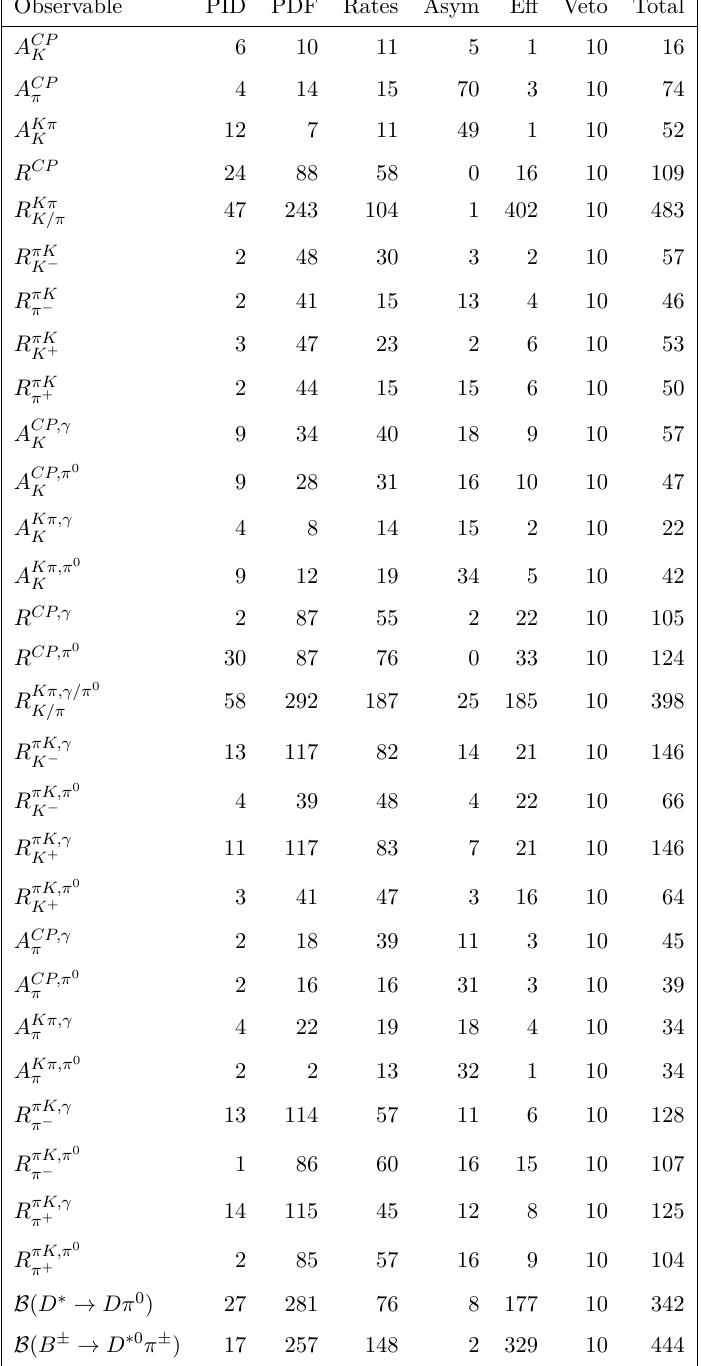
Table 4 . Systematic uncertainties for all observables, where values are quoted as a percentage of the statistical uncertainty for a given observable. The total uncertainty is given by the sum in quadrature of each contribution. PID refers to fixed PID efficiencies, PDF to fixed PDF parameters, Rates to fixed background contributions, Asym to the use of fixed detection asymmetries and background CP asymmetries, Eff to the use of fixed efficiencies from simulation, and Veto to the procedure used to veto fully reconstructed B − → D ∗ h −